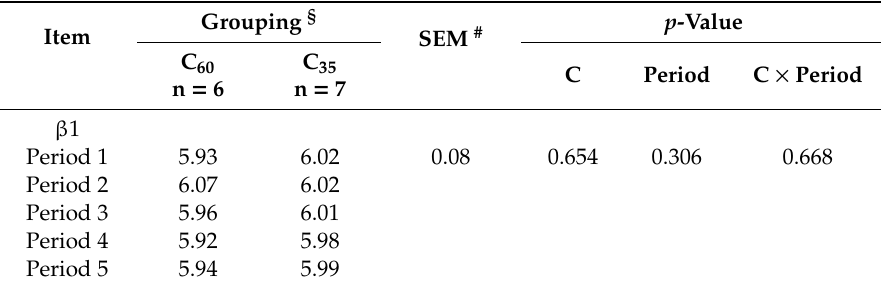
Table 5. E ff ects of concentrate feed proportion in the diet (C) and of period β 1 (describes the inflection point of the curve and represents the average pH of the 24 h period) during period 1 (weeks